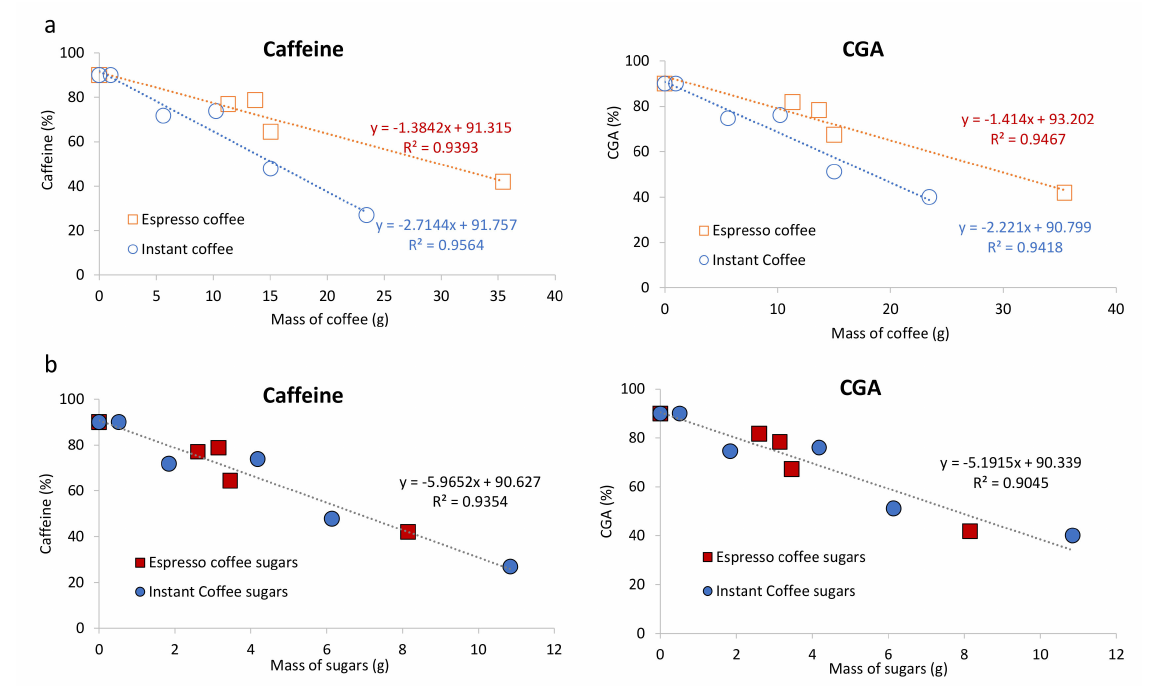
Figure 3. Correlations between the mass of coffee soluble solids in solution ( a ) or sugars content in the beverage ( b ) and the relative permeation by ultrafiltration from 500 mL to 50 mL of Caffeine (left) or CGA